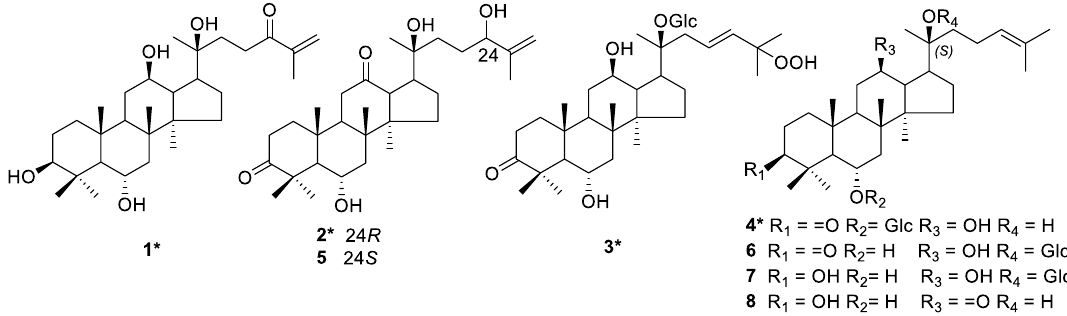
Fig. 1 Compounds 1 – 8 isolated from the rot roots of P.